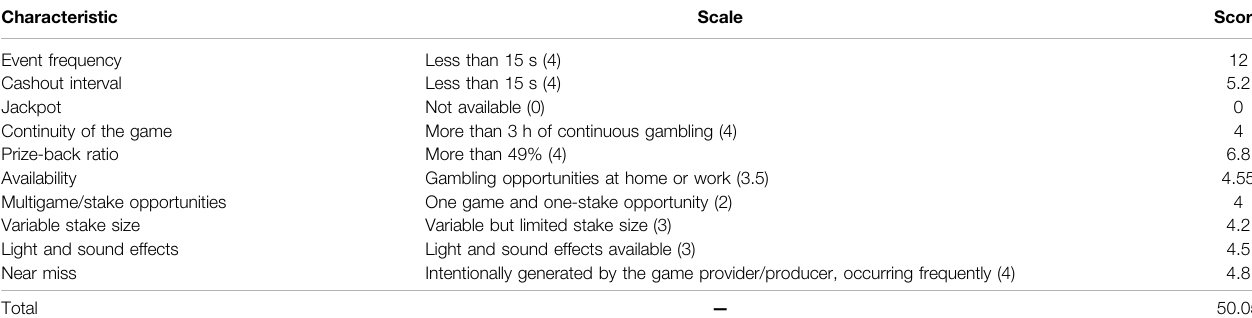
TABLE 1 | Overview of the characteristics according to Meyer et al.